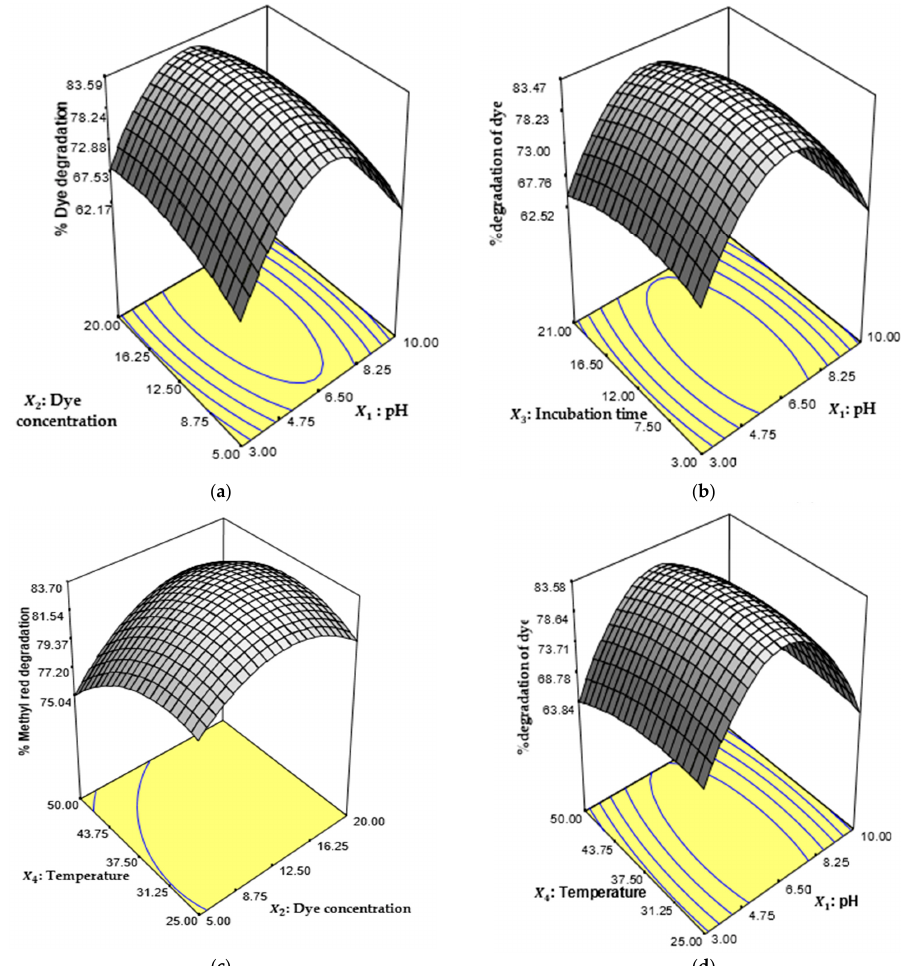
Figure 5. Three-dimensional surface plot for the interaction of ( a ) pH and dye concentration, ( b ) pH and incubation time, ( c ) dye concentration and temperature and ( d ) pH and temperature for the biodegradation of orange II. Table 1. Central composite design for the degradation of orange II dye.